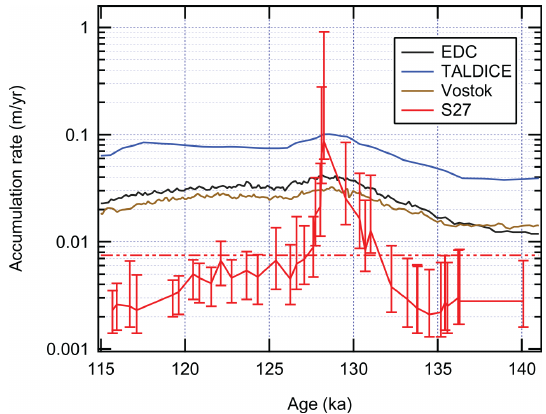
Figure 8. Accumulation rate between 115 and 140ka in S27 (red), Talos Dome (TALDICE; blue), Vostok (brown), and EDC (black). Note that the y axis is plotted on logarithm scales. Accumulation rates of EDC, TALDICE, and Vostok are from Bazin et al. (2013) and the references therein. Error bars represent the 95% confidence interval for S27 accumulation rate estimates. The dashed line in red represents the present-day accumulation rate (0.0075myr − 1 ) in the vicinity of Allan Hills (Dadic et al.,